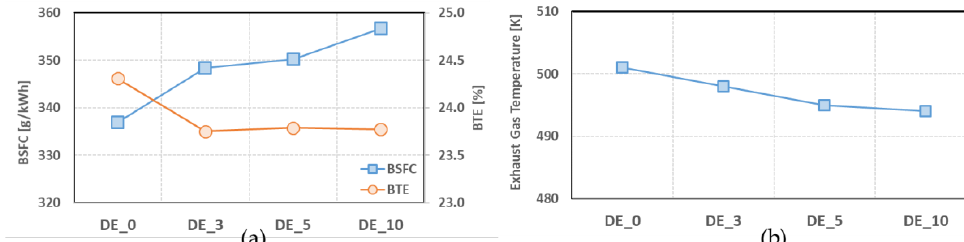
Figure 4. ( a ) The BSFC and BTE, and ( b ) exhaust gas temperature with changing ethanol